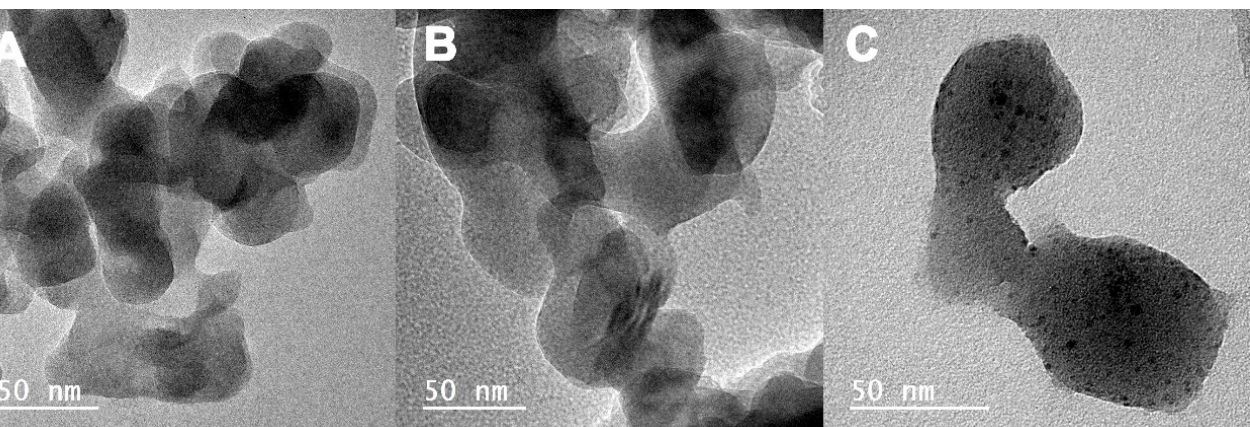
Table 4. Chemical composition of the synthesized NPs as detected by XRF in mol%. Sample Code